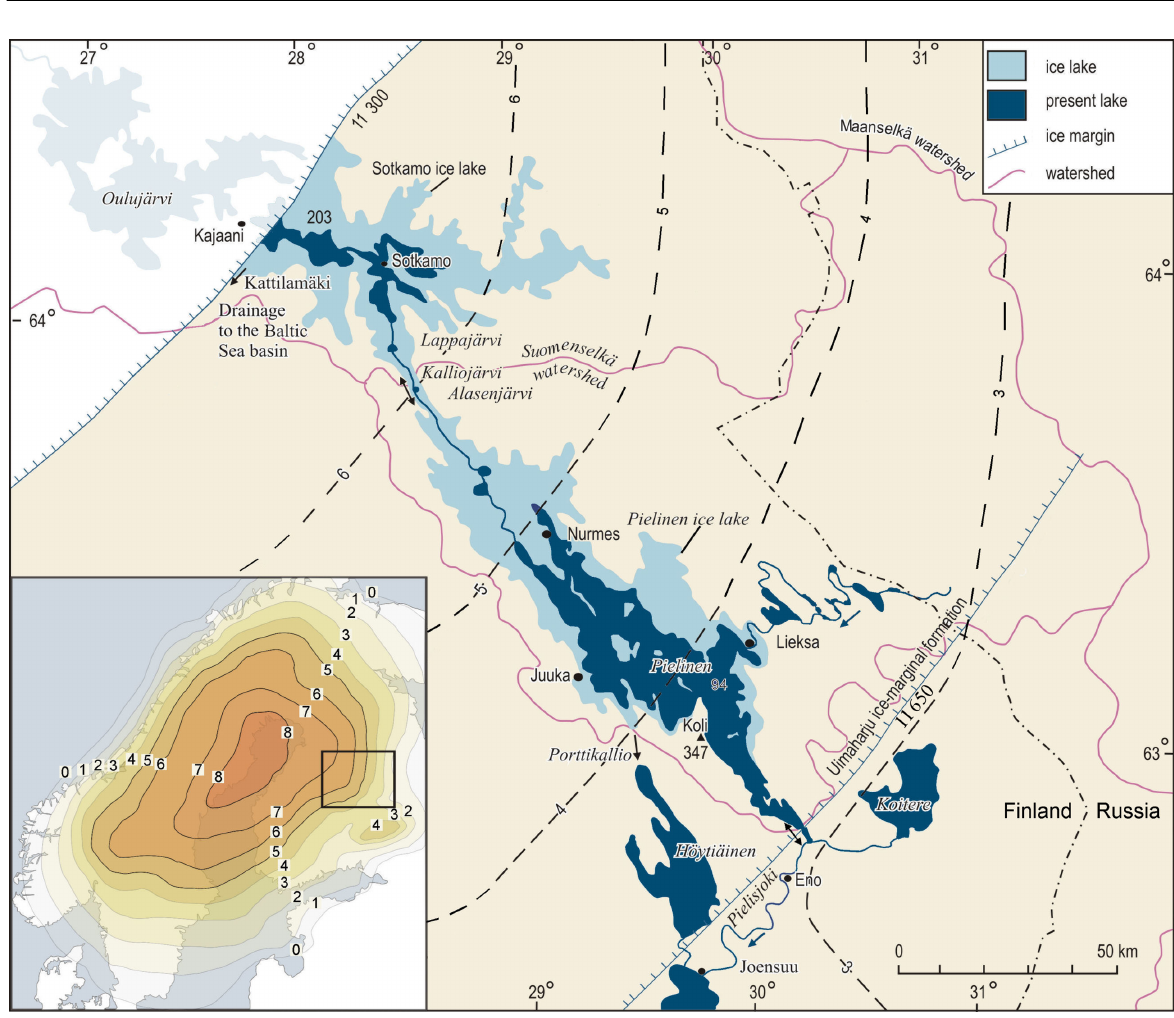
Fig. 1. Study area and its location in the eastern part of the Fennoscandian uplift area and the extent of the Pielinen(cid:150)Sotkamo ice- dammed lake. The modern land uplift isobases mm yr (cid:150)1 (Kakkuri & Virkki 2004) are indicated by the stippled line and the positions of the ice sheet margin at 11 650 cal yr BP and 11 300 cal yr BP by the solid